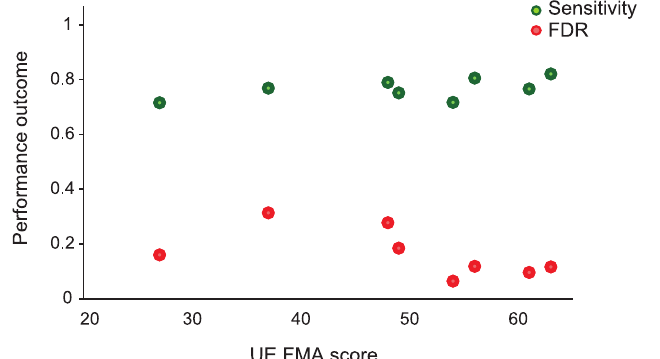
Fig 5. Classification performance of Seq2Seq. (A) Classification performance per primitive class . Prediction outcomes (FP, FN, TP) for activities were combined. Shown are mean ± standard deviation of Seq2Seq sensitivity and FDR for patients in the test set; each dot represents a single subject. Mean sensitivity was high and mean FDR was low for most primitives except stabilizations. (B) Classification performance per activity . Prediction outcomes for primitive classes were combined. Shown are mean ± standard deviation of Seq2Seq sensitivity and FDR for patients in the test set; each dot represents a single subject. Mean sensitivity was high and mean FDR was low for structured